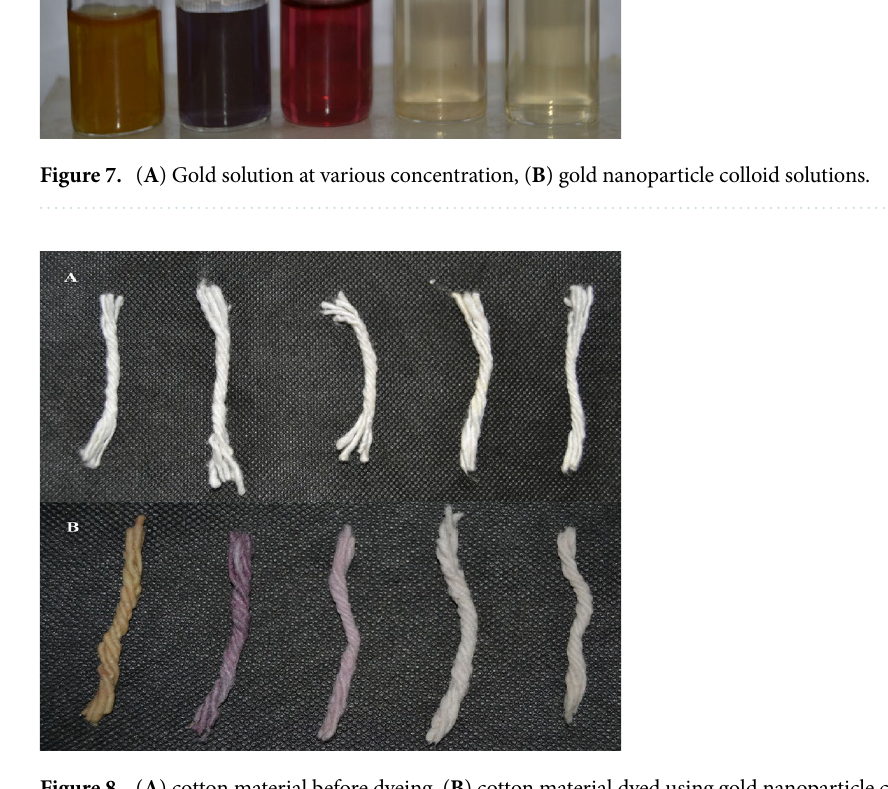
Figure 8. ( A ) cotton material before dyeing, ( B ) cotton material dyed using gold nanoparticle colloid